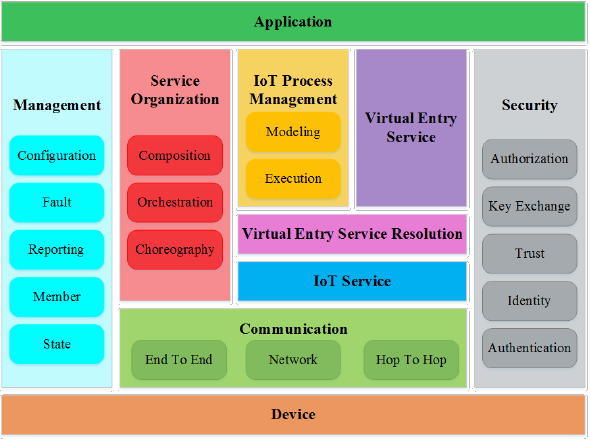
Figure 7. IoT-A Architecture.